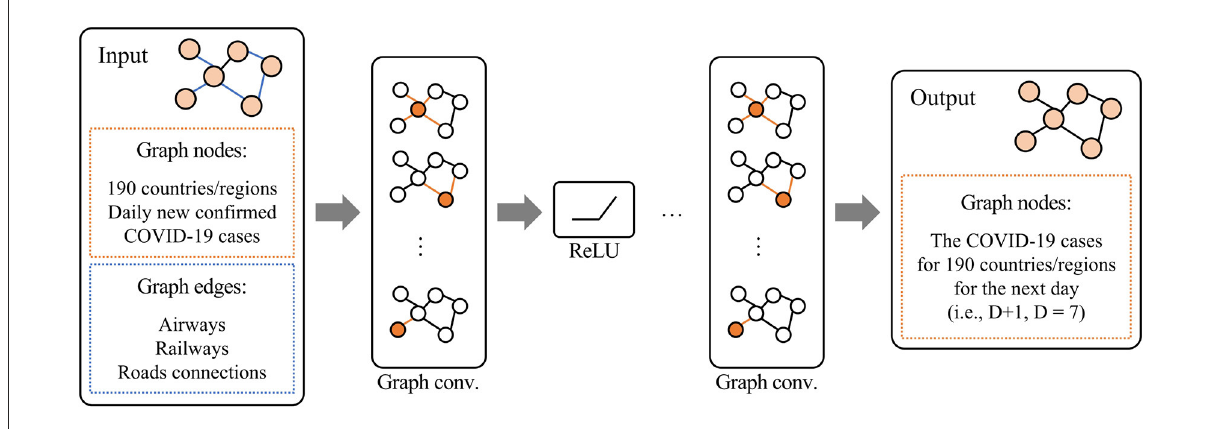
FIGURE1 Proposed three-layer graph convolutional network model.